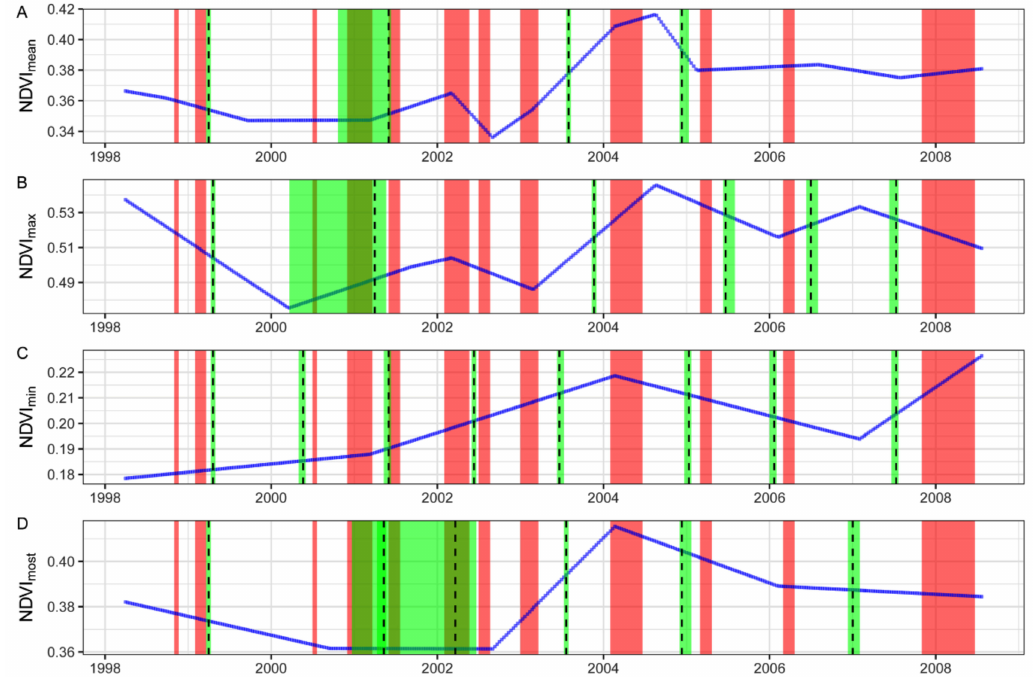
Figure 4. Structure changes for the trend component from STR in ( A ) NDVI mean , ( B ) NDVI max , ( C ) NDVI min and ( D ) NDVI most ; the red background represents the water allocation occupancy; the green background represents the 95% confident abrupt changing period; the dashed line represents the